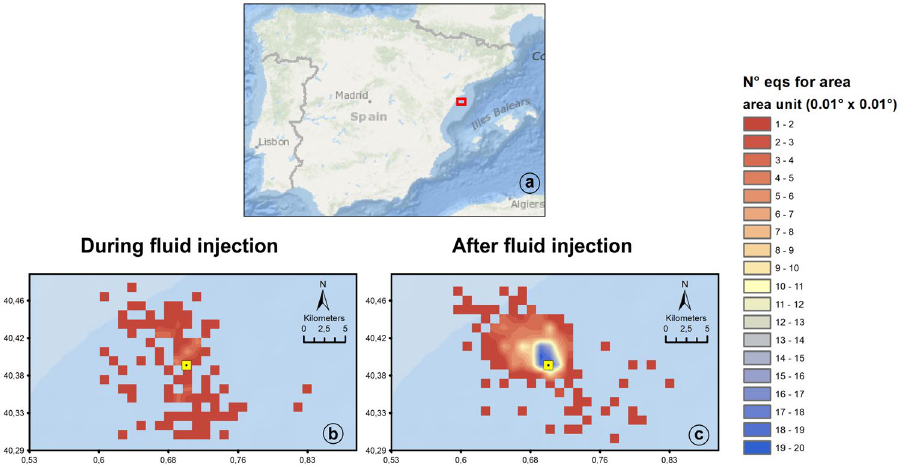
Figure 7. ( a ) shows the location map of the study area. In ( b ) and ( c ), the number of earthquakes for area unit during and after the fluid injection is displayed, respectively. The area unit is 0.01 × 0.01 decimal degrees. The Castor platform is indicated by yellow square. The figure was generated by using the ESRI software, ArcGIS for desktop, version